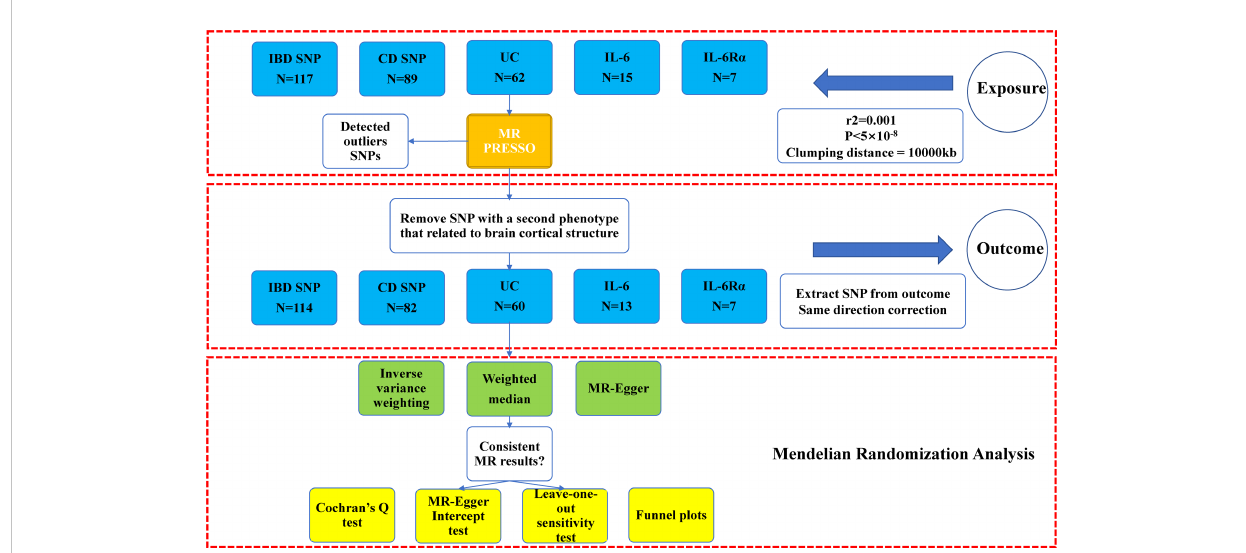
FIGURE 1 Study fl ow chart of the Mendelian randomization study revealing the causality between in fl ammatory bowel diseases, IL-6, and IL-6R a and the brain cortical structure. IBD, in fl ammatory bowel disease; CD, Crohn ’ s disease; UC, Ulcerative colitis; IL-6, interleukin 6; IL-6R a , interleukin-6 receptor subunit alpha. Outcome: brain cortical structure measured by magnetic resonance imaging were with global